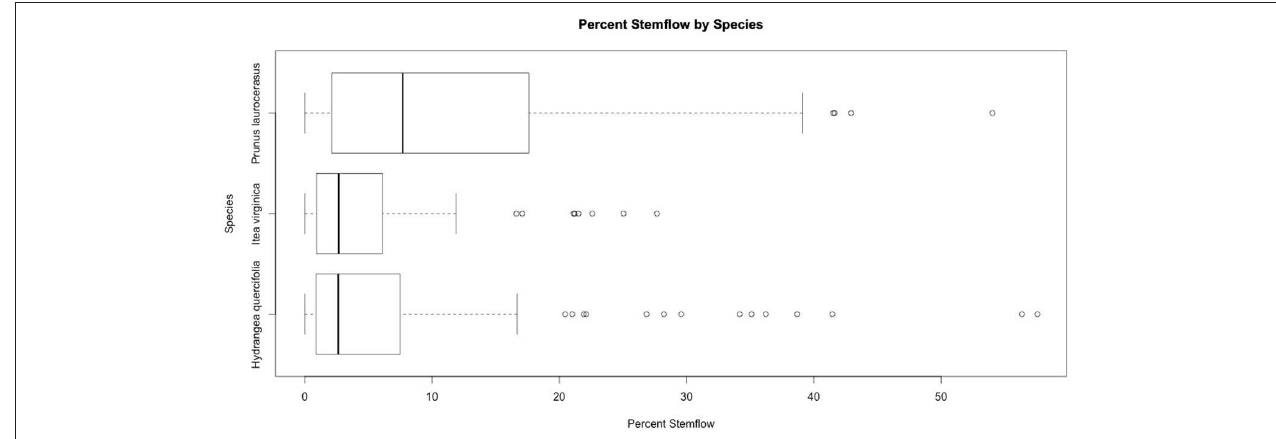
FIGURE 4 | Percent stemflow in individual branches in each event.